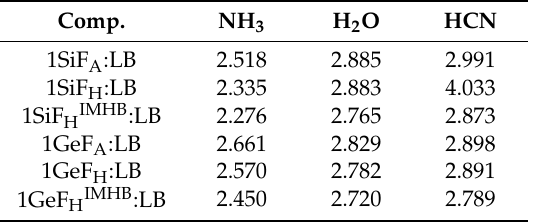
Figure 1. Molecular graphs for 1SiF:LB complexes at the MP2/aug-cc-pVTZ computational level. Green dots correspond to bond critical points. Table 2. Intermolecular distances, T ··· N(O) (T=Si, Ge) in Å for 1TF:LB complexes at the MP2/aug-cc-pVTZ computational